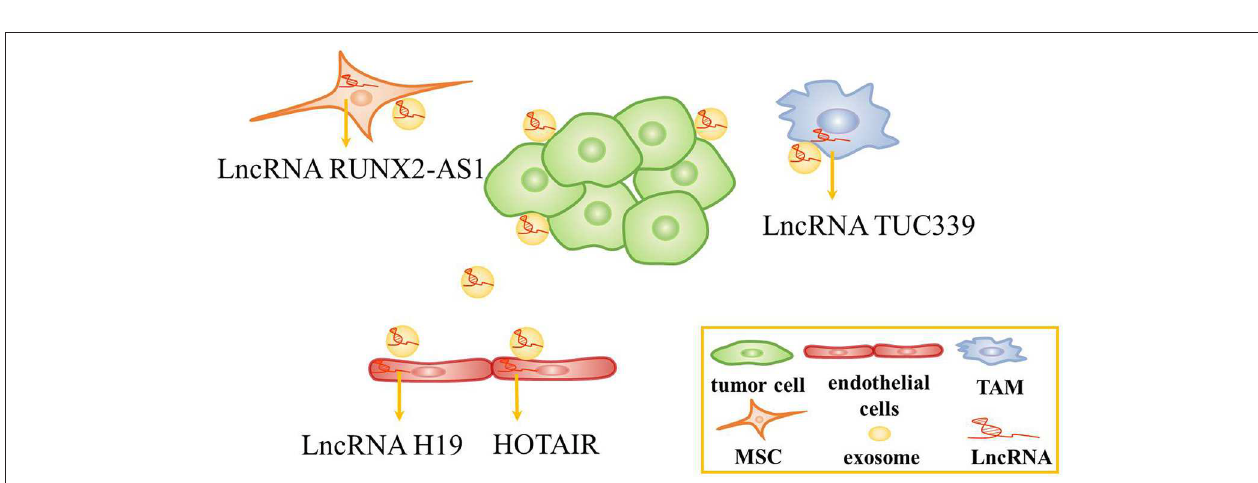
FIGURE 2 | The role of exosomes in the tumor microenvironment. Tumor cells-derived exosomal lncRNAs are transferred to endothelial cells, tumor-associated macrophage (TAMs), and mesenchymal stem cells (MSCs) to alter the function of these